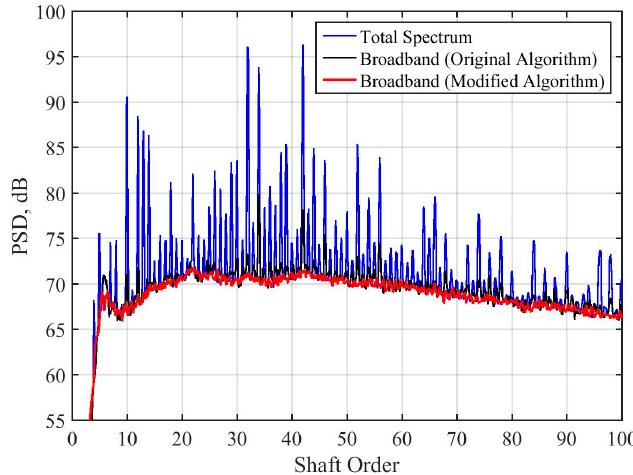
Figure 10. Total and broadband noise spectra from F31/A31 model acoustic data at takeoff condition.